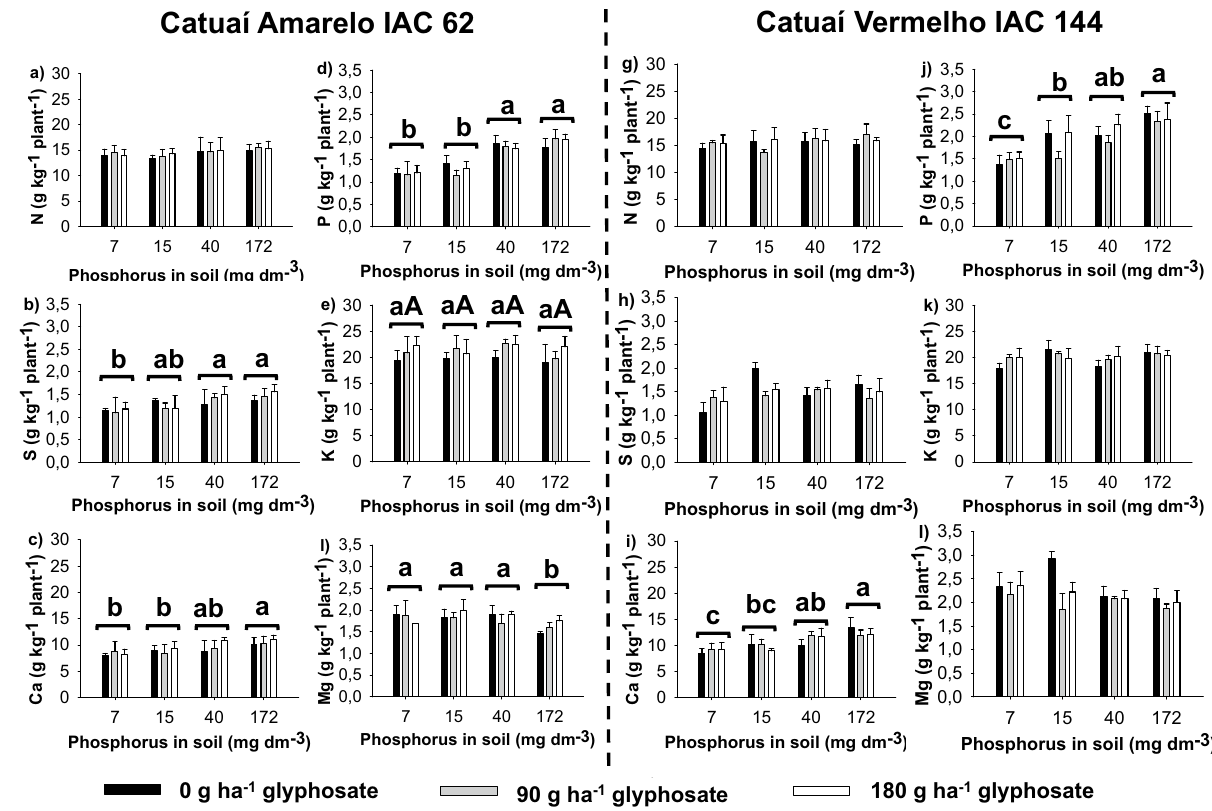
Figure 3. Average nutrient content of the shoot (g kg −1 plant −1 ) of the arabica coffee cultivars Catuaí- Amarelo/IAC-62 and Catuaí-Vermelho/IAC-144, cultivated in soils with different levels of P and subjected to subdoses of glyphosate at 90 days after application. ( a , g ) Nitrogen; ( b , h ) sulfur; ( c , i ) calcium; ( d , j ) phosphorus; ( e , k ) potassium; and ( f , l ) magnesium. For each nutrient, same lower-case do not differ between the soil P contents, and same upper-cases do not differ between the glyphosate subdoses by the Tukey test at 5% probability. ± Vertical bars indicate the standard deviation ( n = 4). Plots were drawn using SigmaPlot ver. 10.0 (Systat Software, Inc., San Jose, USA, www. systa tsoft ware. com).